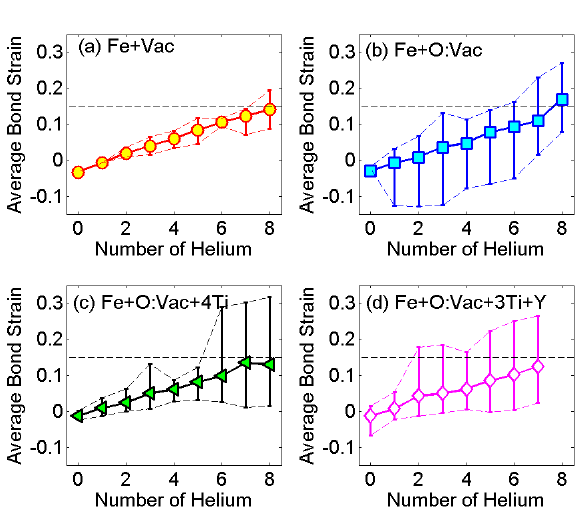
Figure 7. Bond length variations in various reference units: ( a ) Fe+Vac; ( b ) Fe+O:Vac; ( c ) Fe+O:Vac+4Ti; and ( d )